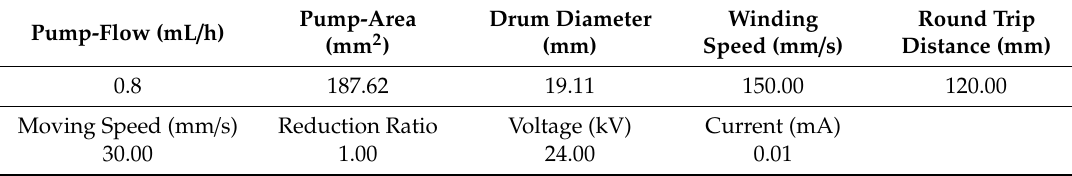
Table 4. Denotations and compositions of PP / PVA / ZIF-8 melt-blown electrospun composite